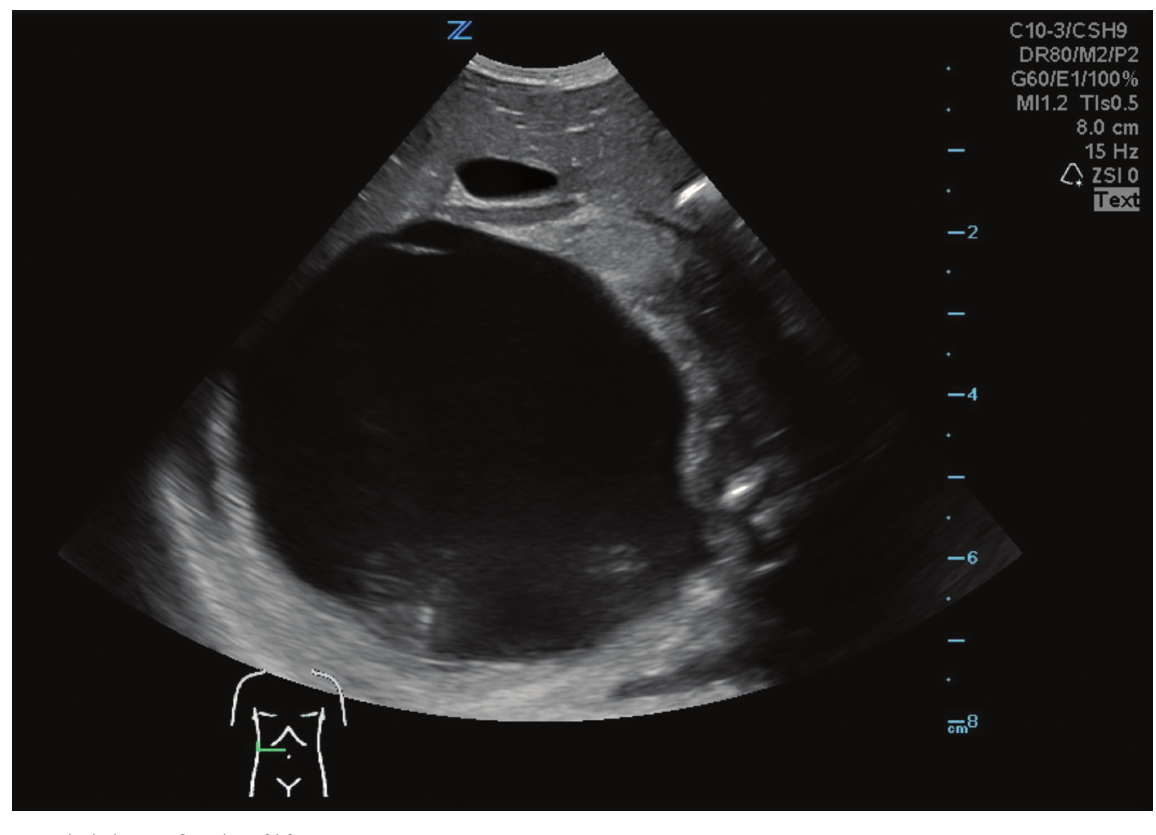
Fig. 1 Right kidney at fi rst day of life.